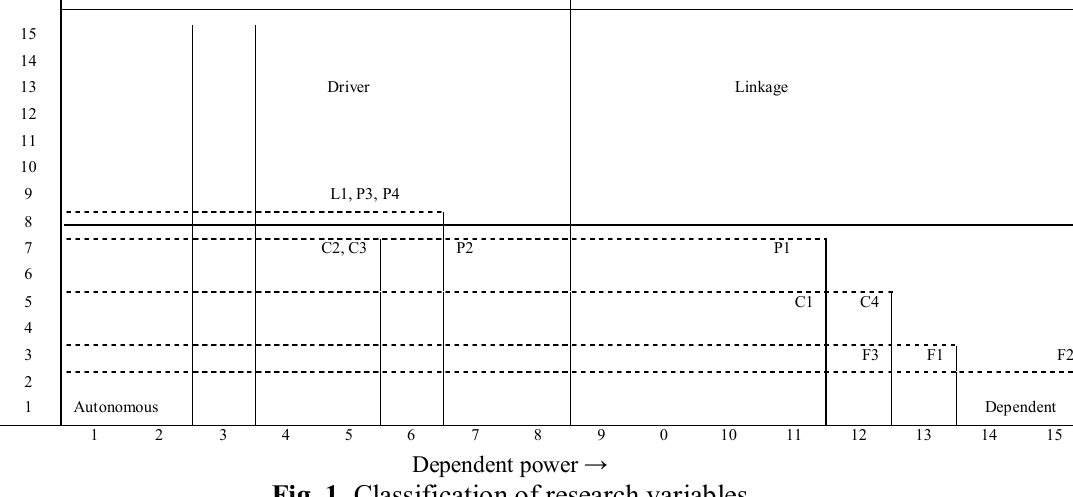
Fig. 1. Classification of research variables